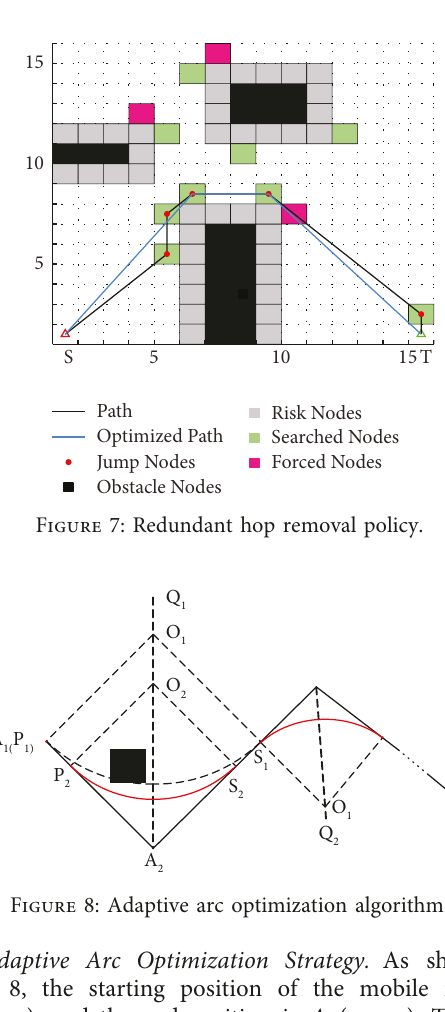
Figure 6: Heuristic function ablation experiment based on JPS-A ∗ . (a) Traditional heuristic function with 4.994 ms. (b) Improved heuristic function with 3.355 ms.